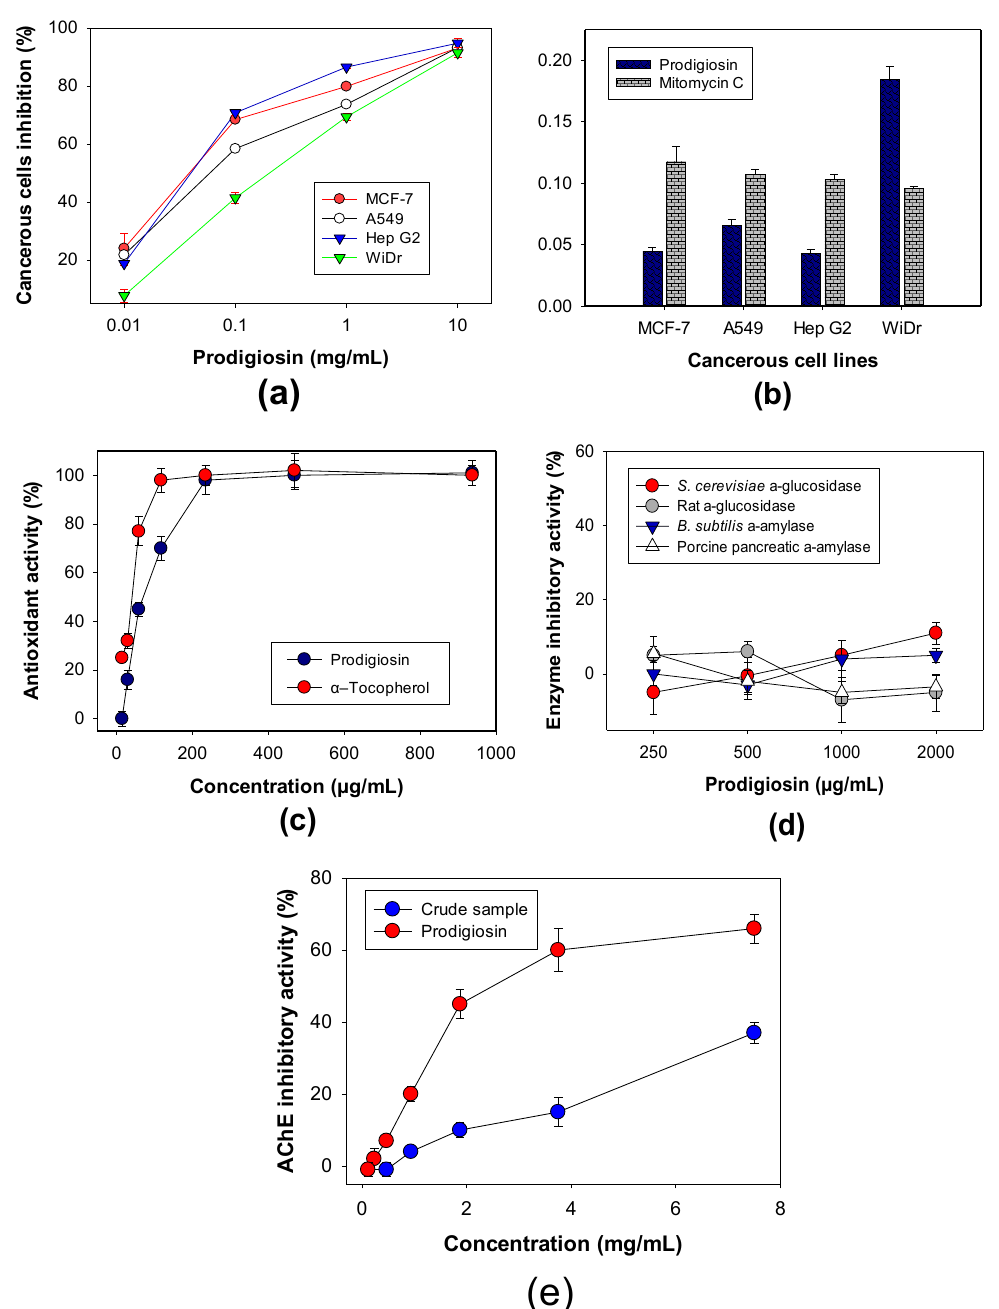
Figure 8. Biological activities of PG, including anticancer activity ( a , b ), antioxidant activity ( c ), enzyme inhibitory activity target in anti-diabetes ( d ), and AChE inhibitory activity: Acetylcholinesterase inhibitory activity ( e ).